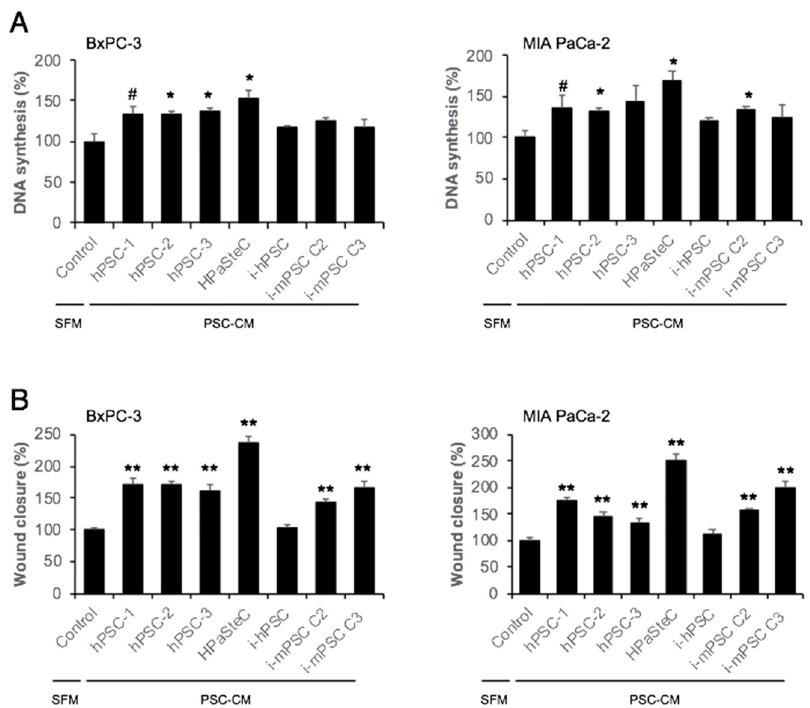
Figure 4. Effect of PSC-CM on pancreatic cancer cell proliferation and migration. ( A ) Cancer cell proliferation: BxPC-3 and MIA PaCa-2 cells were incubated with SFM or PSC-CMs for 24 h, and DNA synthesis was determined by [ 3 H]-thymidine incorporation assay. Data are mean ± SEM of triplicate determinations. ( B ) Cancer cell migration: BxPC-3 and MIA PaCa-2 cells were cultured to confluence, and scratch wounds were established. Images of the wound area were taken immediately after the scratches and 24 h after incubation with SFM or PSC-CMs. The wound area was measured using FIJI software. Data are mean ± SEM of eight scratches for each PSC-CM. # p < 0.1, * p < 0.05, ** p < 0.01 comparing control (SFM) and PSC-CM. PSC, pancreatic stellate cell; hPSC, human primary PDAC-derived PSC culture; HPaSteC, PSCs from normal human pancreas; i-hPSC, immortalized human PSCs; i-mPSC C2 and C3, immortalized mouse PSCs clone 2 and 3; PSC-CM, PSC-conditioned medium; SFM, serum-free DMEM.